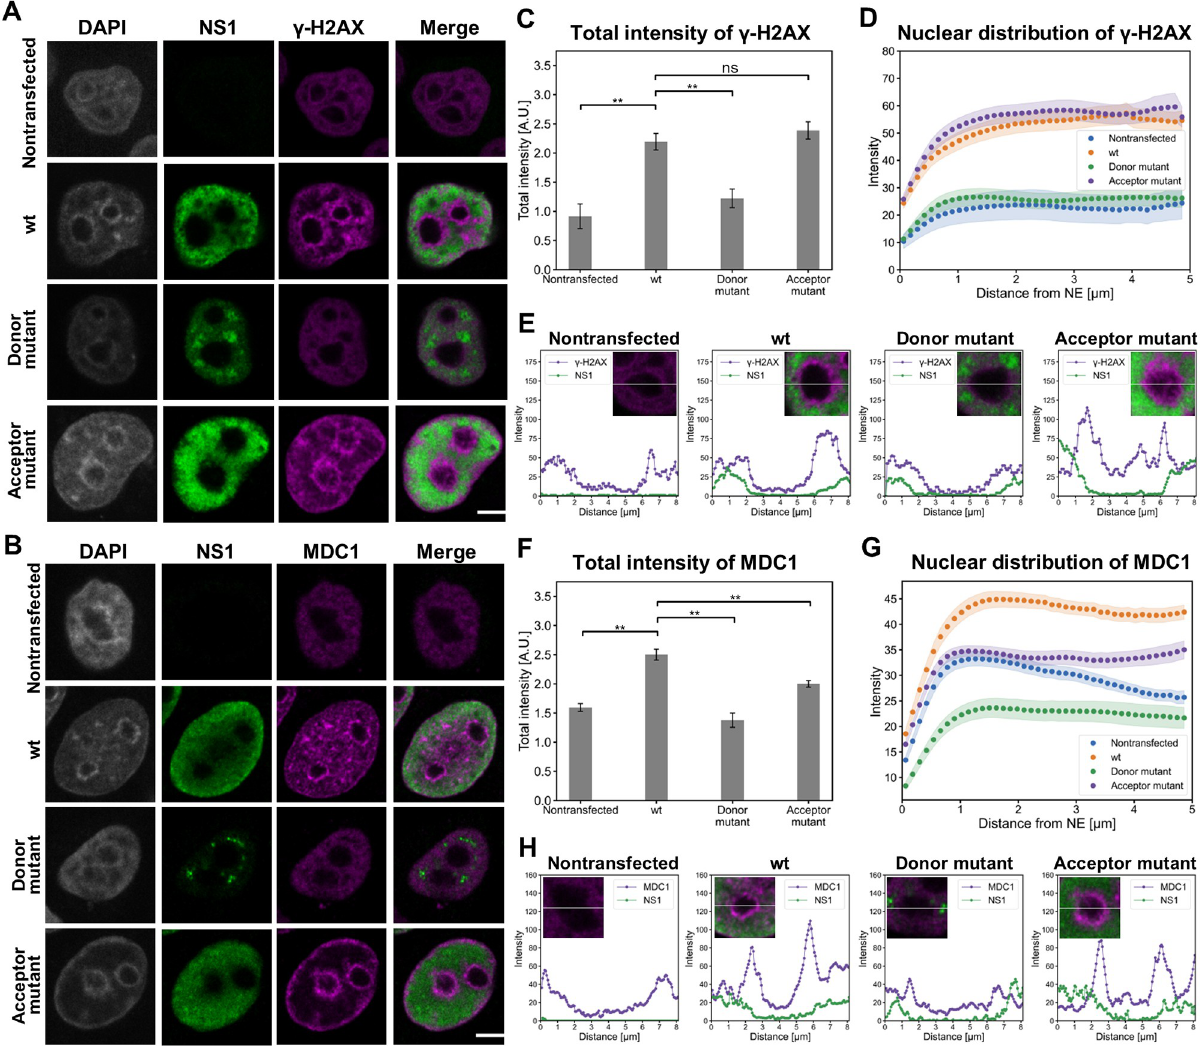
Fig 8. Mutation of NS2 induce alteration in the amount and distribution of DDR proteins. Representative confocal images show the nuclear localization of NS1 (green), ( A ) γ -H2AX (magenta), (B ) MDC1 (magenta) and DAPI staining (gray) in HeLa cells without transfection or at 24 hpt with wt, NS2 splice donor and acceptor mutants. Scale bars, 5 μ m. (C ) Total fluorescence intensities of γ -H2AX together with ( D ) its nuclear distribution as a function of increasing distance from the NE in nontransfected, wt and NS2 mutants transfected cells (n = 29). (E) Intensity line profiles of γ -H2AX (purple) and NS1 (green) measured through the nucleoli. ( F ) Fluorescent intensities and ( G ) nuclear localization of MDC1 from the NE (n = 28). The error bars show the standard error of the mean. (H) Intensity line profiles of MDC1 (purple) and NS1 (green) measured through the nucleoli. Statistical significances were determined using Dunnett’s multiple comparison test. The significance values shown are denoted as �� (p < 0.01), � (p < 0.05) or ns (not significant). Fluorescent intensity profiles of ( G ) γ -H2AX (magenta) with NS1 (green), and ( H ) MDC1 (magenta) with NS1 (green) in zoomed